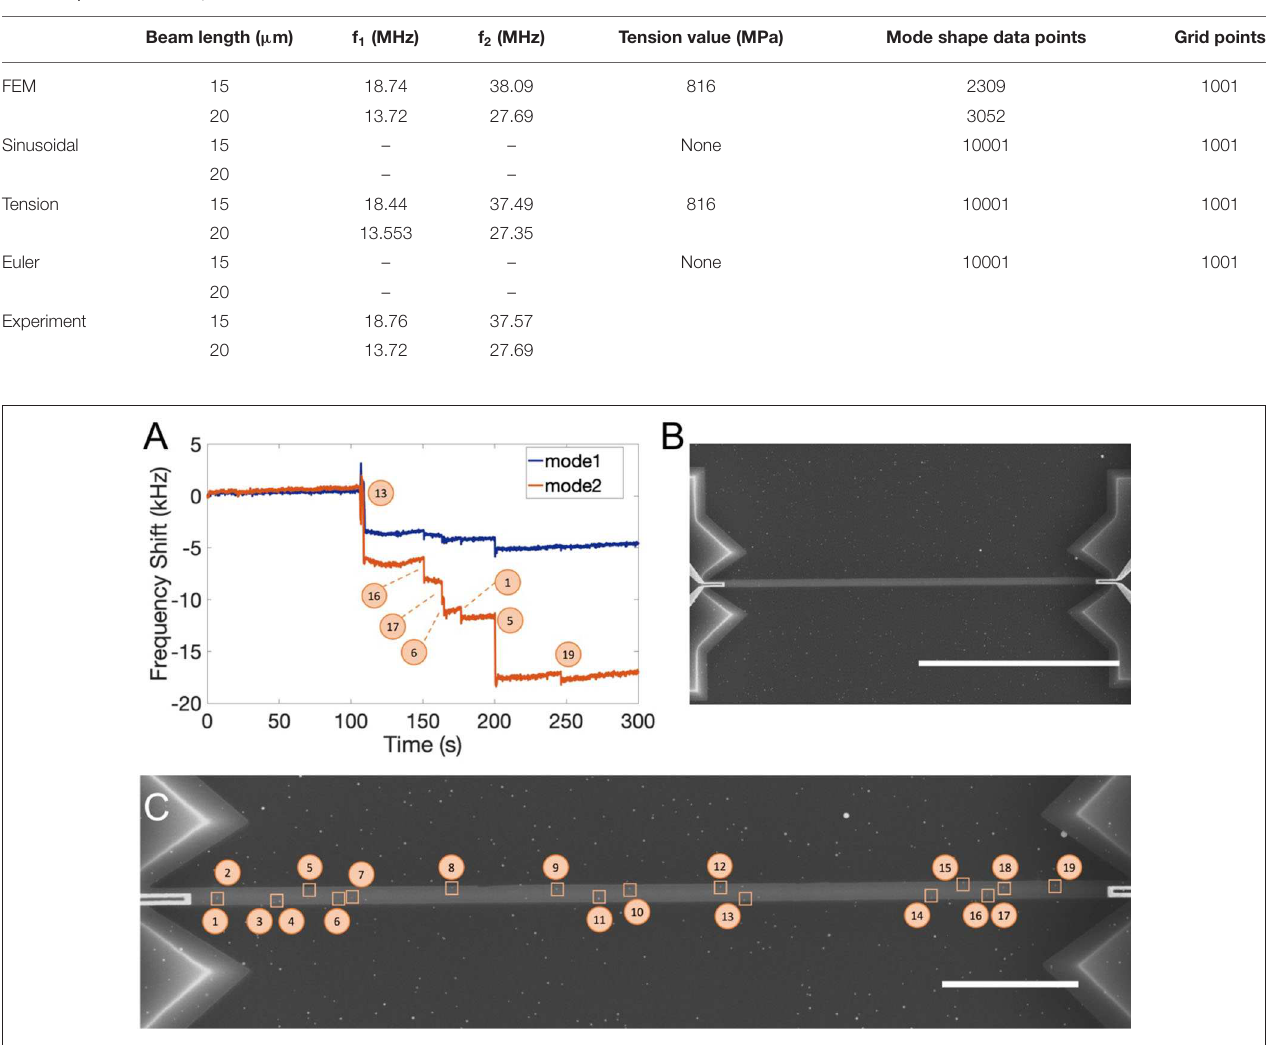
Frontiers in Mechanical Engineering |